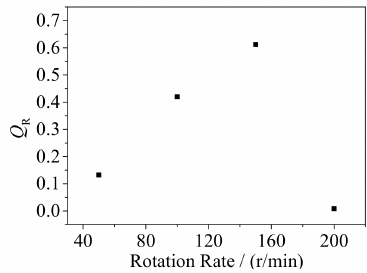
Figure 14. E ff ect of the rotation rate on the comprehensive quality factor of the